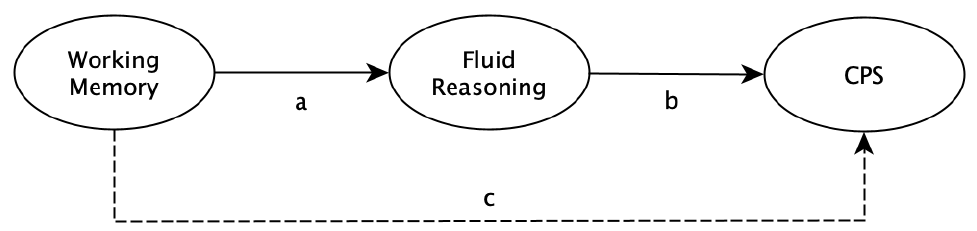
Figure 3. Structural models for all analyses. Model 1 (without dashed line): Complex problem solving (CPS) variance is explained by fluid reasoning, in which variance is explained by working memory. Model 2 (with dashed line): A direct path from working memory to CPS is added to Model 1. Measurement models are omitted for the sake of